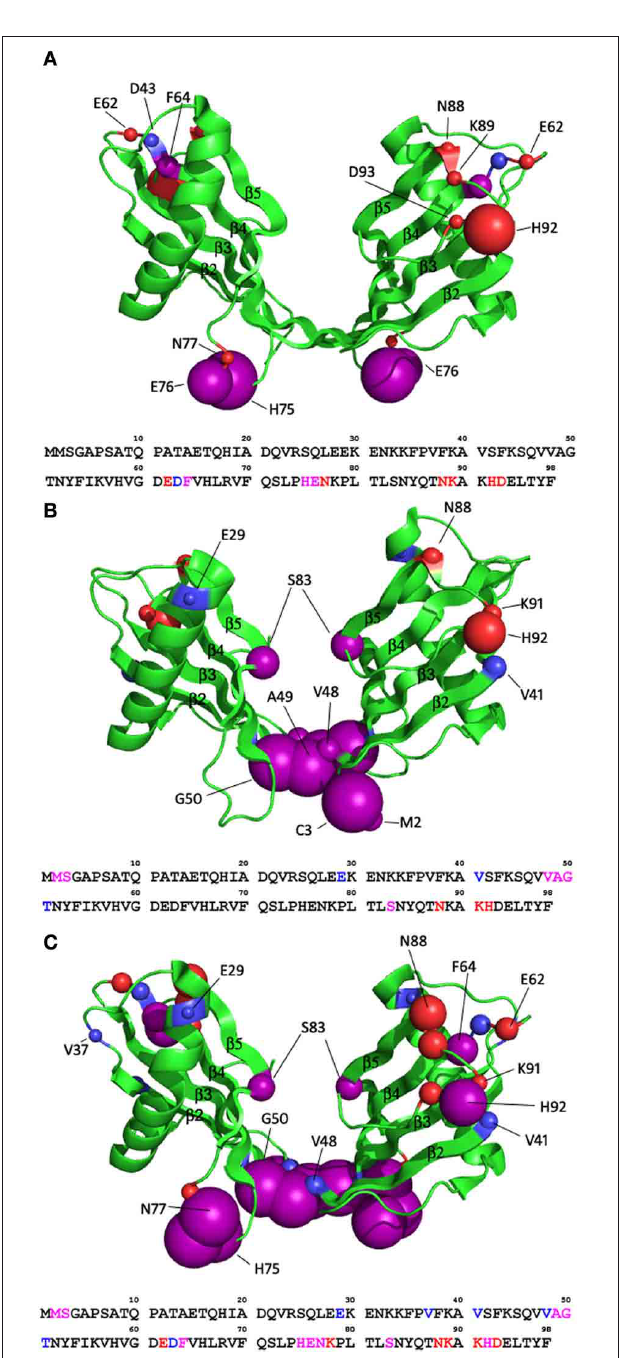
FIGURE 3 | How in vitro fibrillisation conditions affect the structure of the stefin B dimer (pdb code 2OCT). (A) The effect of lowering the pH from 6.0 to 4.7. (B) The effect of titrating in 10% TFE at pH6.0. (C) The effect of combining these two effects and transferring the protein to fibrillisation conditions, pH4.7, 10% TFE. The residues of stefin B that are significantly affected are shown as spheres with a radius proportional to the change in chemical shift observed (0.075–0.2 ppm in proton shift or 0.55–1 ppm nitrogen shift). Purple spheres represent residues with significant change in both proton and nitrogen chemical shifts while red and blue represent residues with significant change in proton or nitrogen only chemical shifts